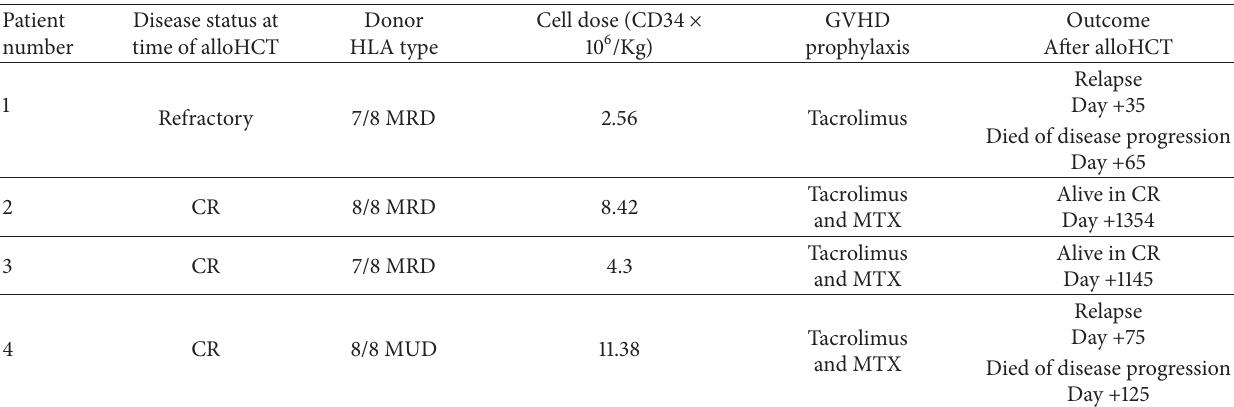
Table 2: alloHCT data